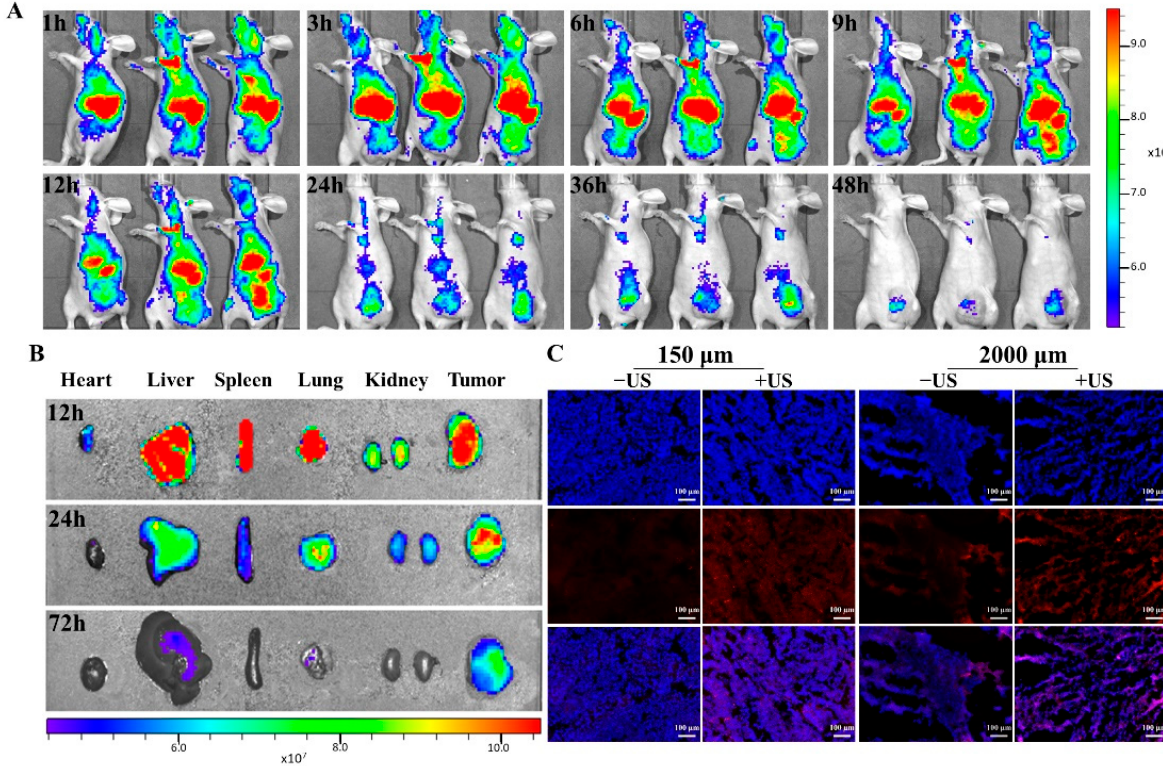
Figure 5. In vivo fluorescence imaging of PL in the orthotopic MDA-MB-231 tumor model. ( A ) Fluorescence imaging of PL in nude mice at different time points; ( B ) distribution of PL in the main organs and tumors of nude mice; ( C ) fluorescence microscope was used to observe the location and distribution of DOX in tumor tissue and cells with/without US irradiation (scale bar = 100 μ m).